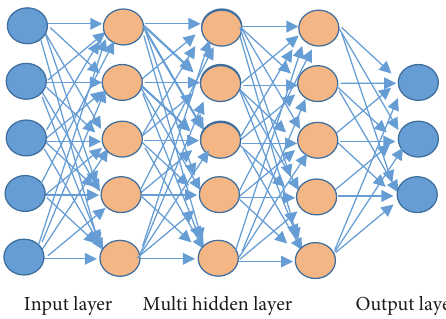
Figure 3: An example of ANN architecture [11,